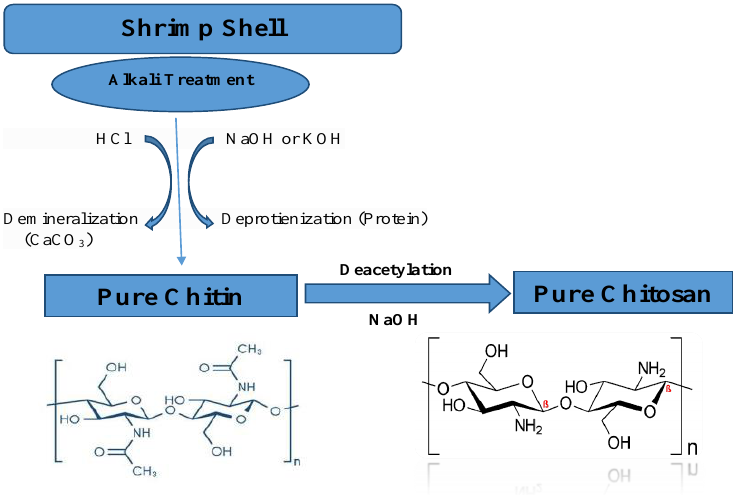
Figure 1. Simplified chemical extraction method of chitin and chitosan from shrimp shells.